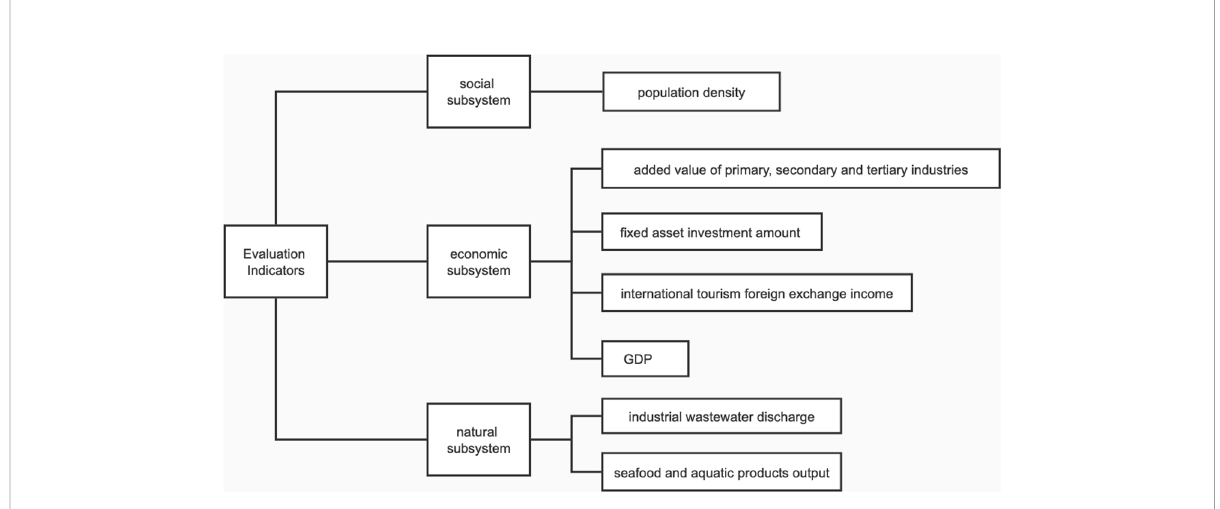
FIGURE 3 Model indicators for assessing the effects of ICZM.